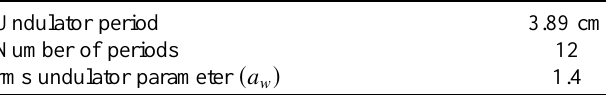
TABLE II. Undulator parameters for NISUS undulator.